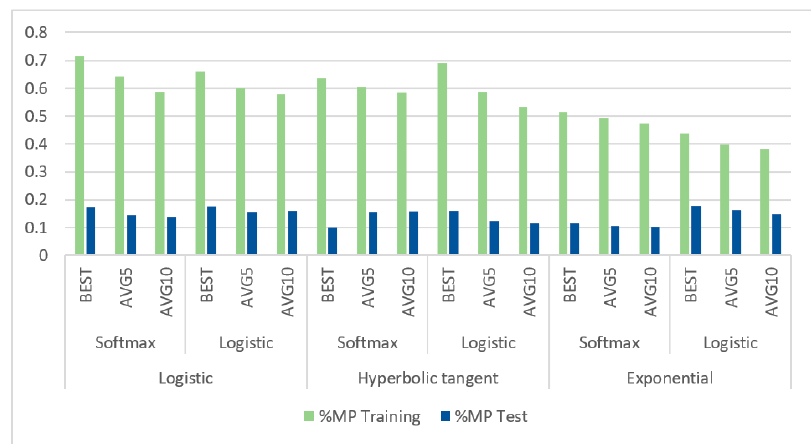
Figure 6. Value of the %MP indicator obtained in the SANN taking into account the activation function used in the hidden layer (logistic, hyperbolic tangent, exponential) and in the output layer (logistic, softmax).